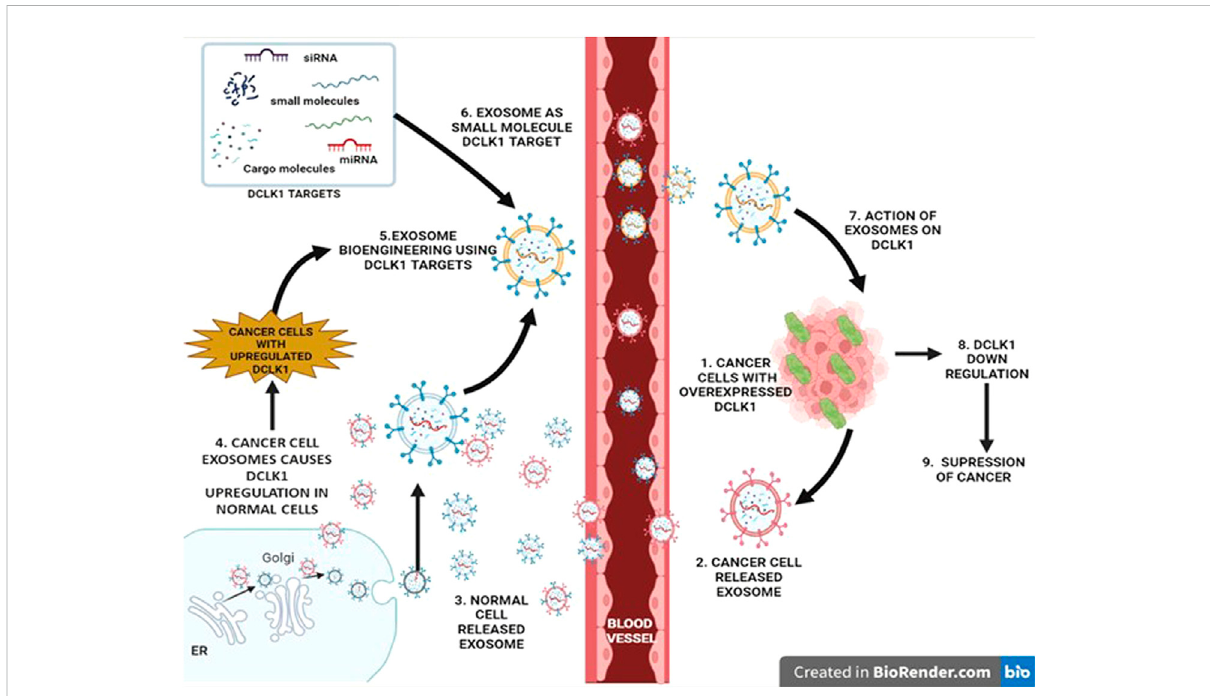
FIGURE 5 Regulatoryrole of exosomes in DCLK1 expression. Exosomes are nanosized vesiclesthat exhibit properties and cargo of the cell that it releases from. They function as signal transducers via paracrine activity upon entering the blood vessel. Exosomes released from the cancer cells exhibit cancer cell properties, which upon interaction with normal cells results in transition into cancer causing malignant cells with upregulated DCLK1. Bioengineering exosomes by integrating DCLK1 targets to its cargo may lead to DCLK1 downregulation potentially in DCLK1-upregulated cancer